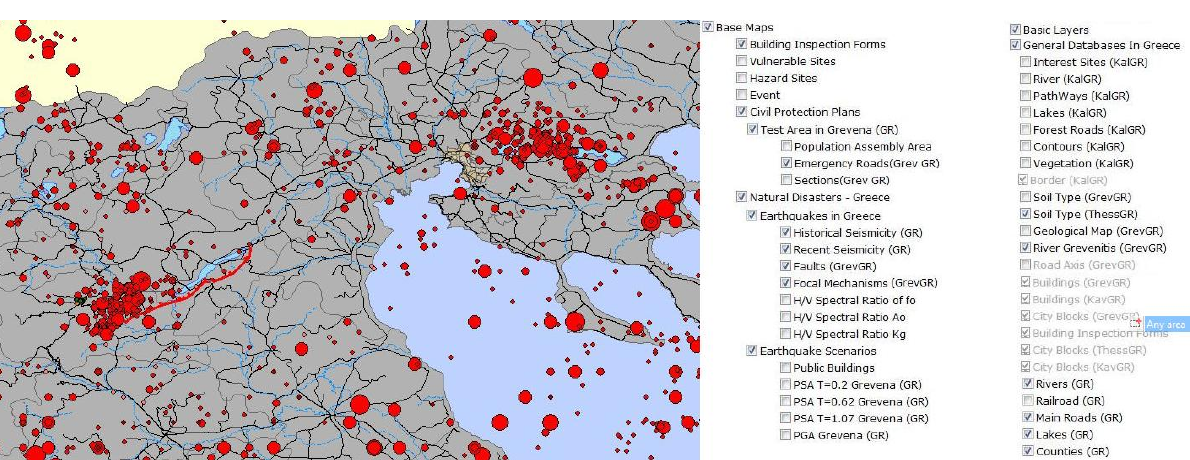
Figure 8. Map of the broader Thessaloniki area showing combined various categories of data that can assist the evaluation of the vulnerability of structures (soil type, earthquake epicenters, faults etc .). A more detailed legend of base maps and basic layers of information included in the system is shown at the right side of the figure.